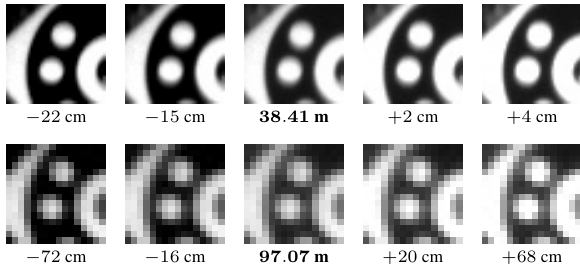
Figure 10: Effect of different exposures on the estimated dis- tance for two frames at nominal distance of 38 . 41 m and 97 . 07 m (darker on the left, brighter on the right, original in the